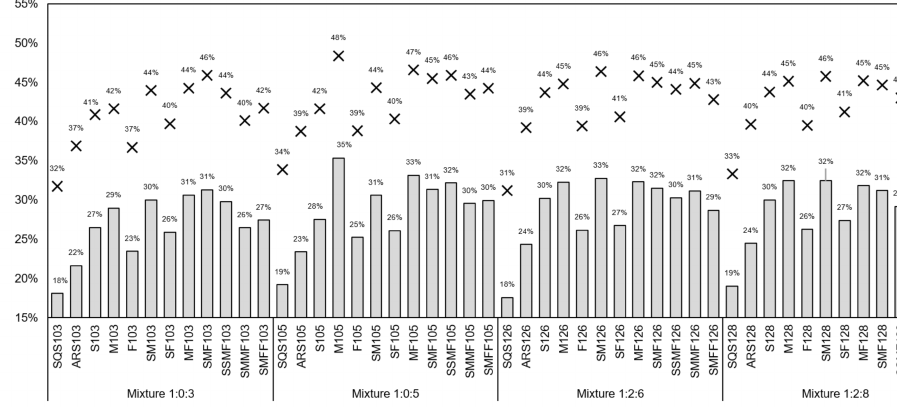
Figure A5. Water absorption.